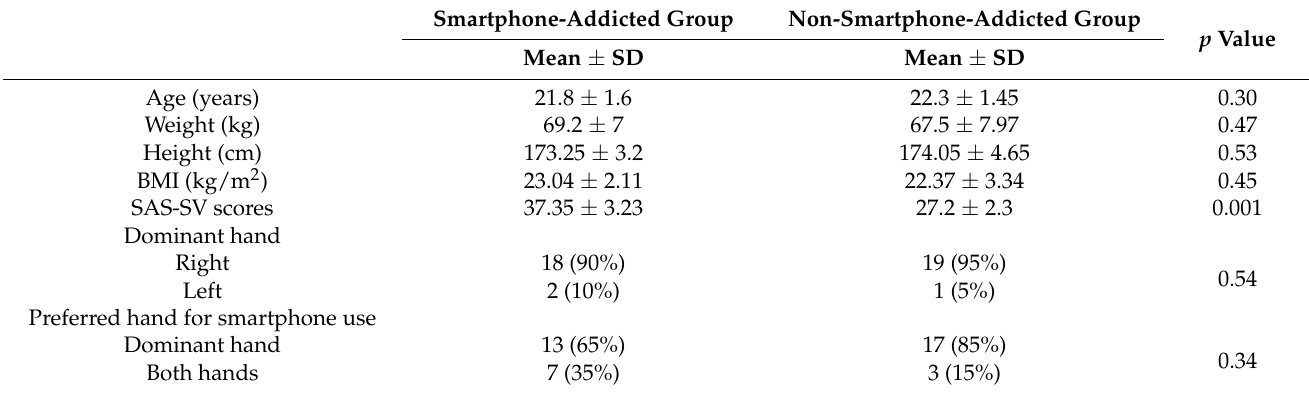
Table 1. Between-group comparison of participants’